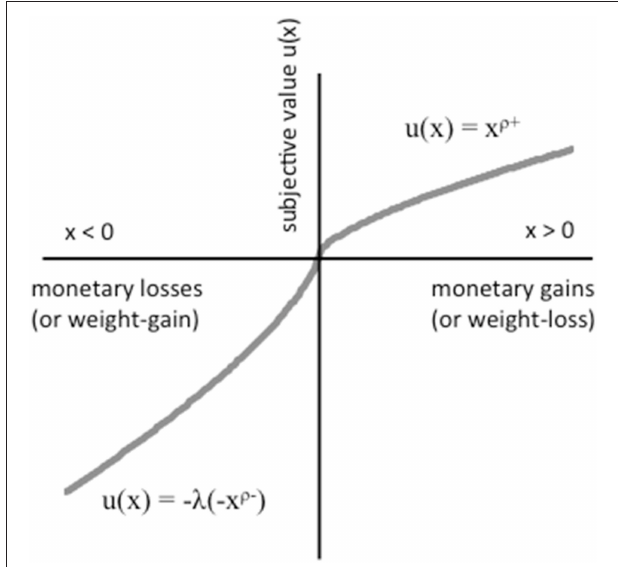
FIGURE 1 | A hypothetical value function based on prospect